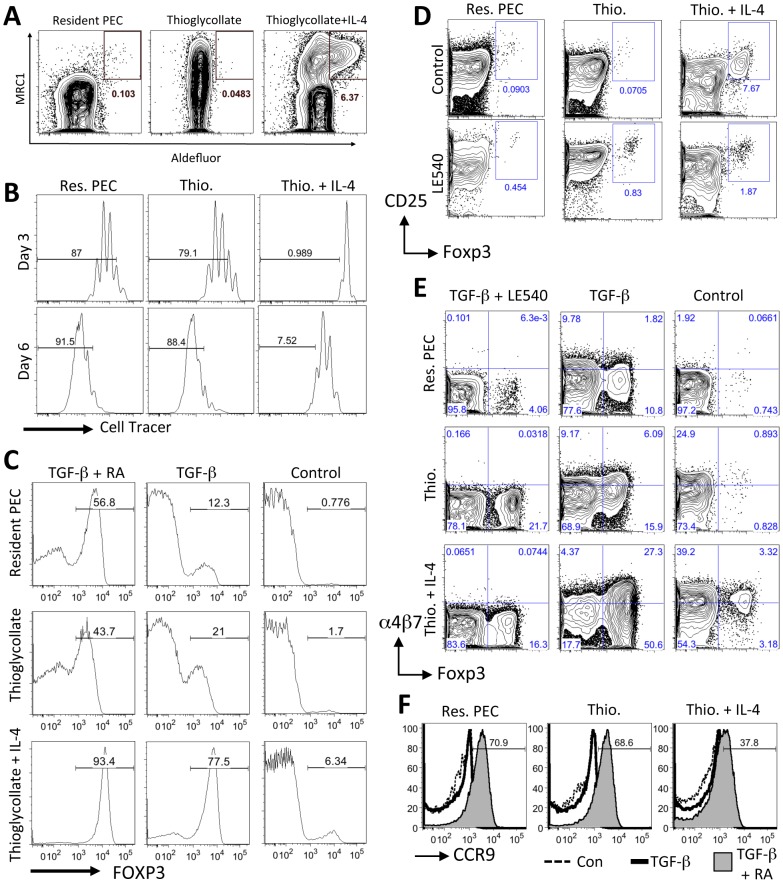
AAMφ have an enhanced capacity to induce Foxp3 expression in T cells.(A) Flow cytometric analysis of aldehyde dehydrogenase (ALDH) activity in peritoneal cells using the Aldefluor assay. Representative contour plots are gated on live F4/80+CD11b+ cells. (B) Flow cytometric analysis of activated (anti-CD3+IL-2) labeled naïve CD4+ cells (gated on CD11b−, CD3+, live Hoechst negative, CD4+ cells) cultured with peritoneal macrophages from control untreated mice (Res. PEC), mice injected with Thioglycollate (Thio.) or mice injected with Thioglycollate and IL-4 (Thio.+IL-4). Gates show the frequency of cells that have undergone more than 2 rounds of cell division (at Day 3) or more than 4 rounds of cell division (at Day 6). (C) Flow cytometry histogram plots showing the percentage of co-cultured CD4+ cells expressing Foxp3 (at Day 6) when activated with anti-CD3 and IL-2 alone (Control) or with exogenous TGF-β1 (2 ng/ml) or TGF-β1 and RA (100 nm). (D) Flow cytometry contour plots showing the percentage of CD25+, Foxp3+ CD4+ T cells after 6 days of co-culture with the RA inhibitor LE540 (1 µM). (E) Flow cytometry contour plots showing the effects of TGF-β1 and LE540 on the expression of α4β7 integrin and Foxp3 in co-cultured (Day 6) CD4+ cells. (F) Flow cytometry histogram plots showing the induction of CCR9 by TGF-β1 and RA (solid grey) when compared to CD4+ cells cultured with anti-CD3 and IL-2 alone (Control, dashed line) or with the addition of TGF-β1 only (solid thick line). Results are all representative of two or three independent experiments.